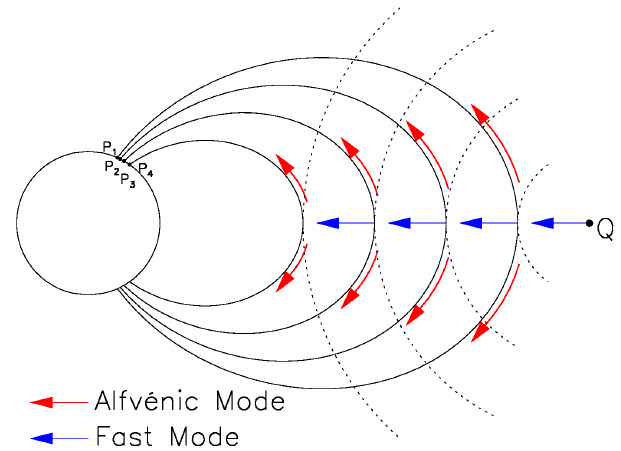
Fig. 6. MHD wave propagation inside the Earth’s magnetosphere from a source Q to an observer P 1 , P 2 , P 3 , P 4 on the ground. The path shown is that identified by Tamao (1964) as the least attenuated